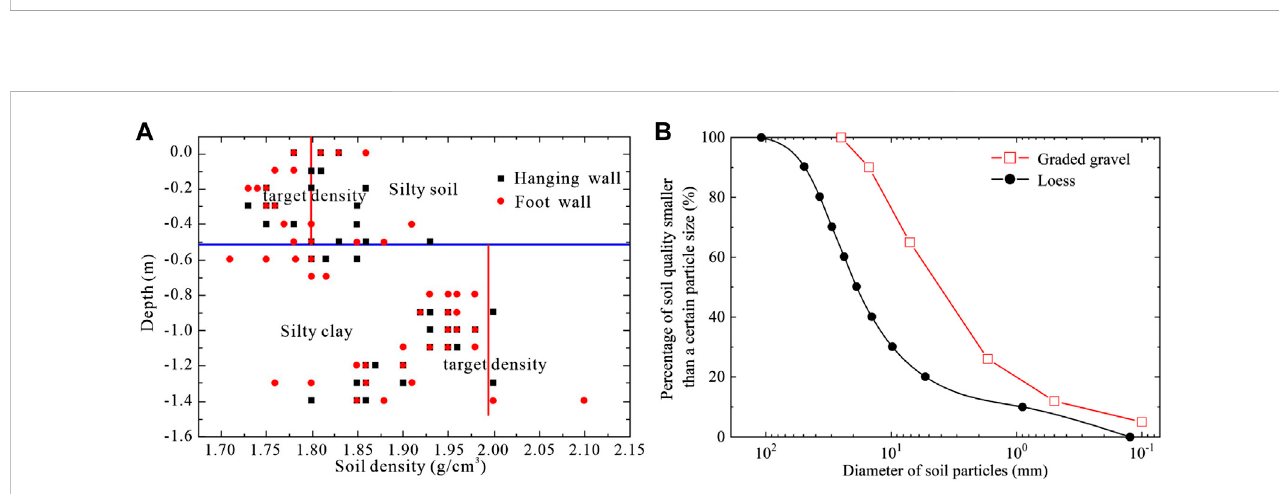
FIGURE 6 Site fi lling soil quality control. (A) sampling results of foundation soil; (B) particle distribution curves of graded gravel.